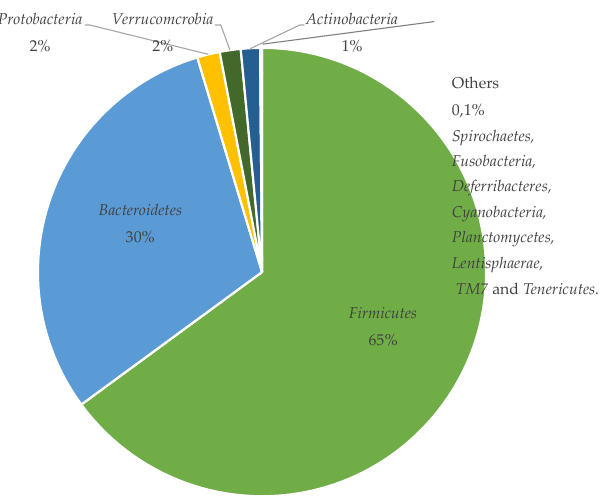
Figure 2. The phyla composition of the human gut from Yang et al. [148] .